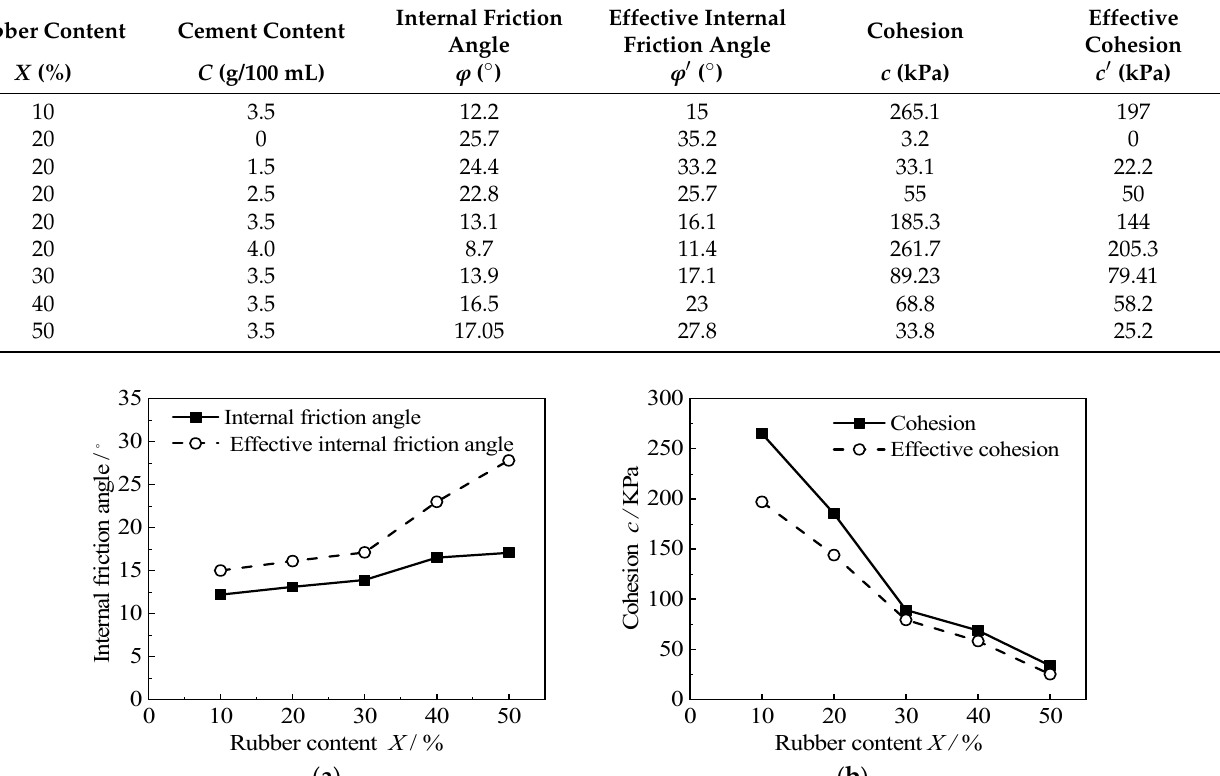
Figure 15. The relationship between the shear strength index of RCS soil and rubber content when C = 3.5 g/100 mL. ( a ) Relationship between rubber content and internal friction angle, ( b ) Relationship between Rubber Content and Cohesion.